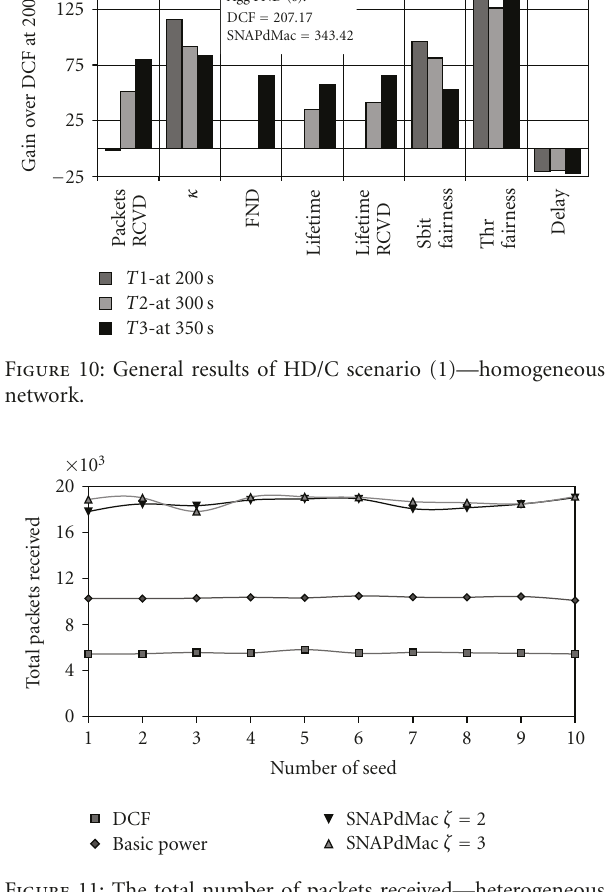
Figure 11: The total number of packets received—heterogeneous network, Basic access